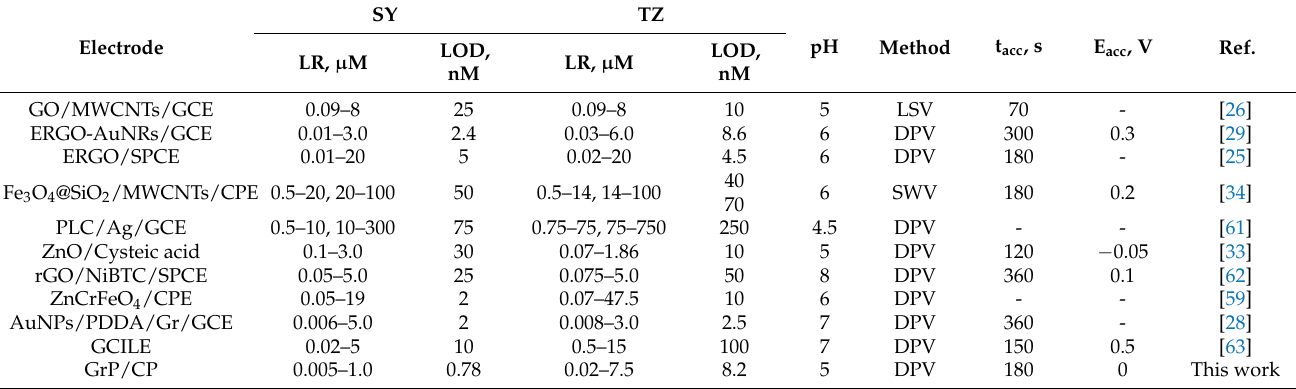
Table 2. Analytical characteristics and conditions of SY and TZ using different sensors.